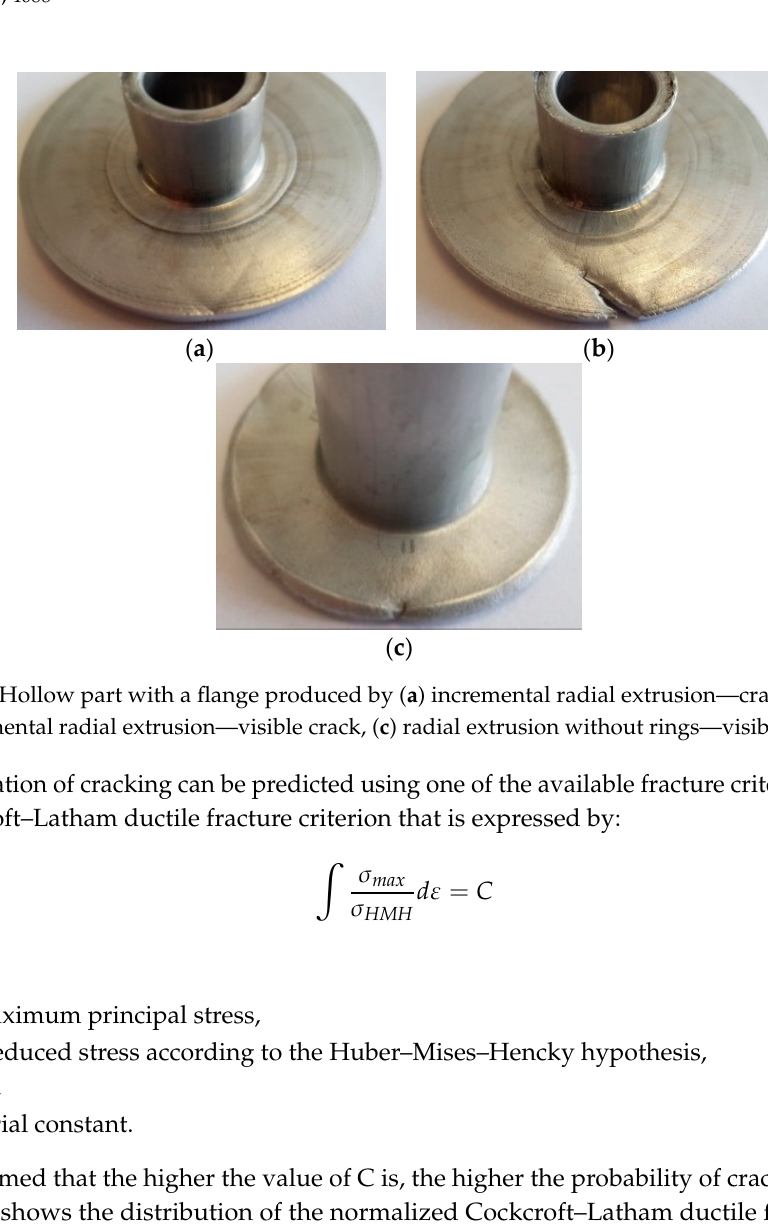
Figure 5. Hollow part with a 56 mm diameter flange: ( a ) perspective view, ( b ) axial section.